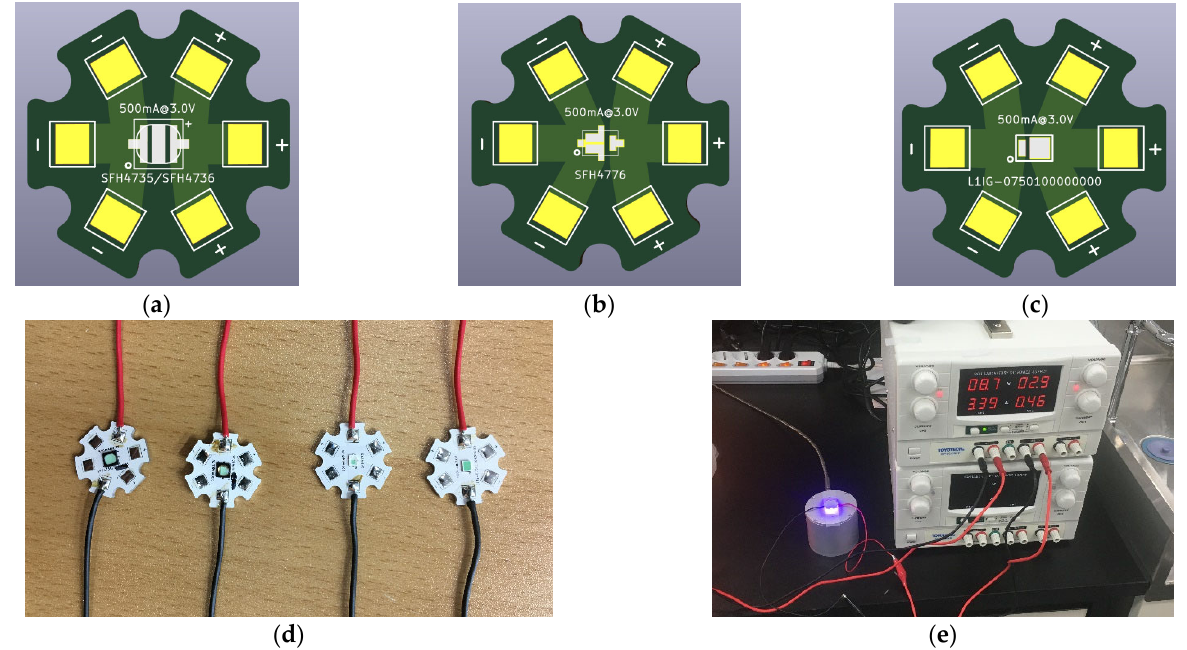
Figure 1. Schematic of ( a ) SFH4735 and SFH4736, ( b ) SFH4776, and ( c ) L1IG-0750100000000; ( d ) SFH4735, SFH4736, SFH4776, and L1IG-0750100000000 LED modules with MCPCBs; ( e ) Vis/NIR spectrum data acquisition system with a power supply, irradiation integration sphere, and